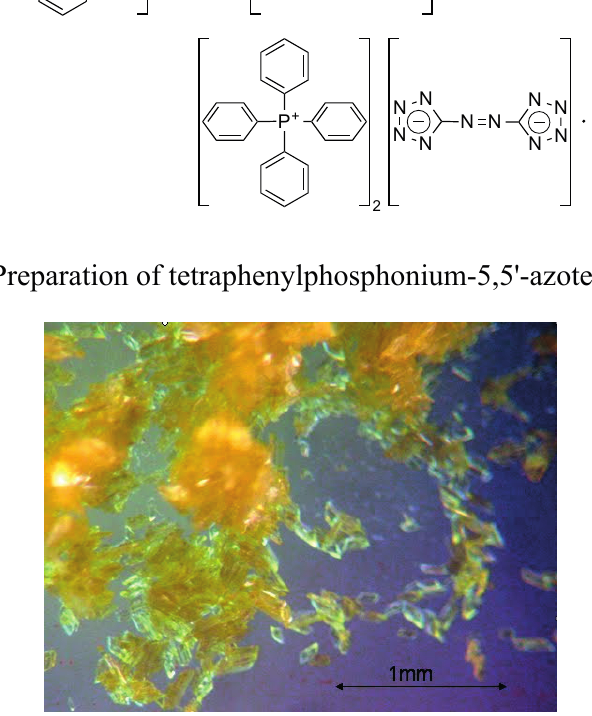
Figure 1. Crystals of tetraphenylphosphonium-5,5'-azotetrazolate ( 1 ). Tetraphenylphosphonium-5,5'-azotetrazolate ( 1 ) was fully characterized through IR and NMR ( 1